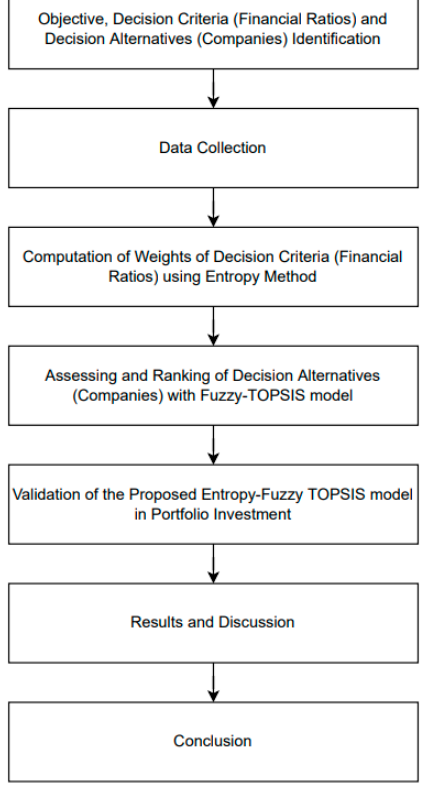
Figure 1. Process flowchart